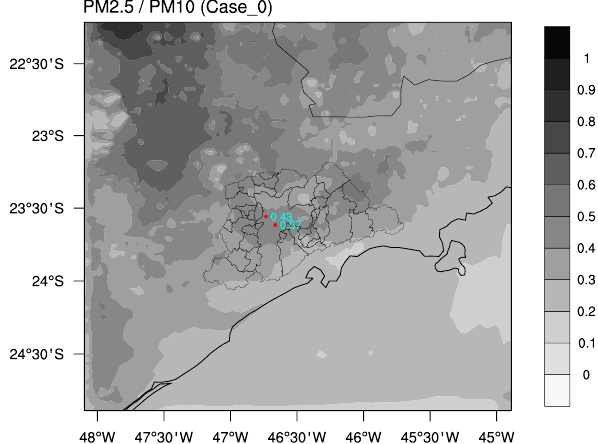
Figure 11. The predicted average surface distribution of PM 2 . 5 con- centrations for the whole study period in the 3km modelling do- main. Red dots represent the locations of the measurement sites with information on PM 2 . 5 , whereas cyan numbers represent the observed average PM 2 . 5 concentration in those sites: 23.4µgm − 3 in IPEN-USP, 21.3µgm − 3 in IAG-USP, and 22.2µgm − 3 in CON.